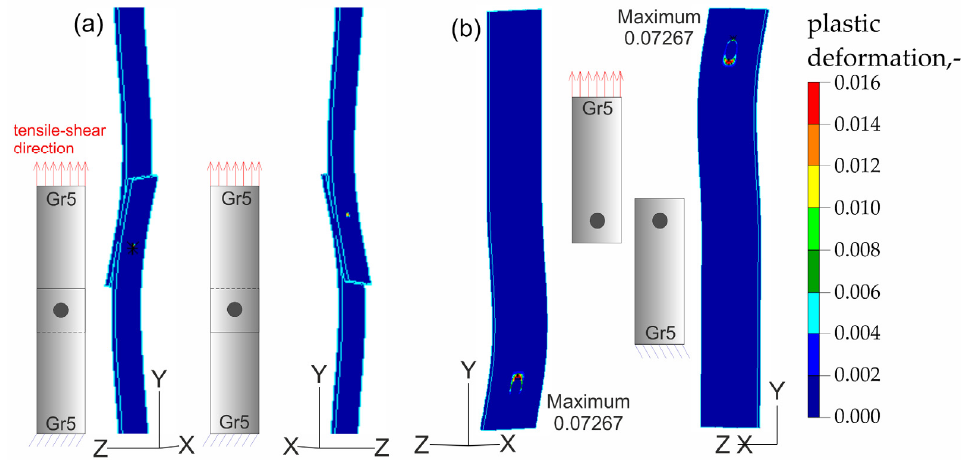
Figure 19. Distribution of plastic deformations in the Gr5–Gr5-1 joints: ( a ) on the surface of the entire joint and ( b ) on the inner surfaces of the joints.